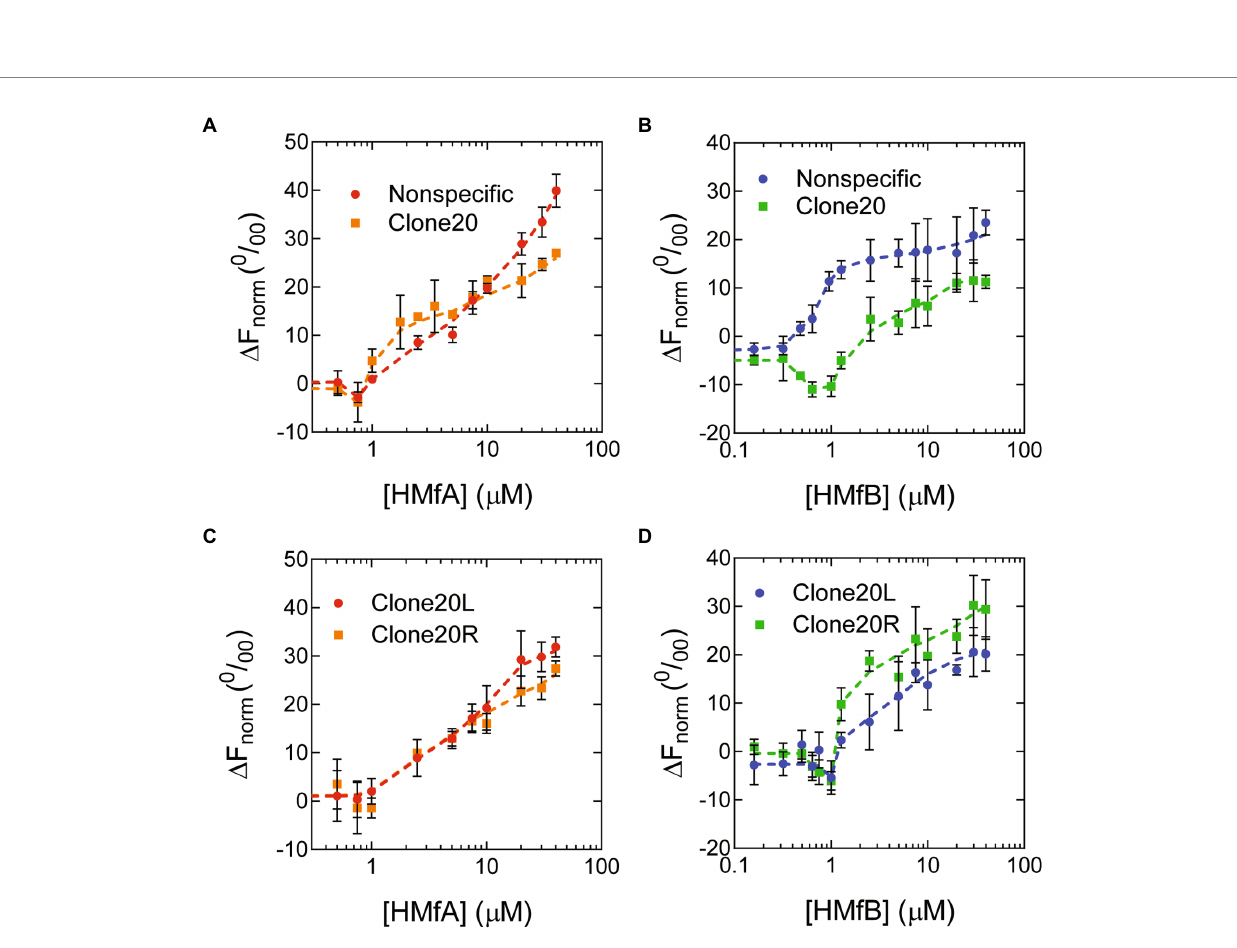
FIGURE 3 Binding of HMf proteins to short DNA substrates using Microscale Thermophoresis. Normalized thermophoresis curves of Nonspecific or Clone20 DNA as a function of (A) HMfA or (B) HMfB or of Clone20L or Clone20R as a function of (C) HMfA or (D) HMfB. Error bars indicate the standard deviation of three independent measurements. Dashed lines are lines to guide the